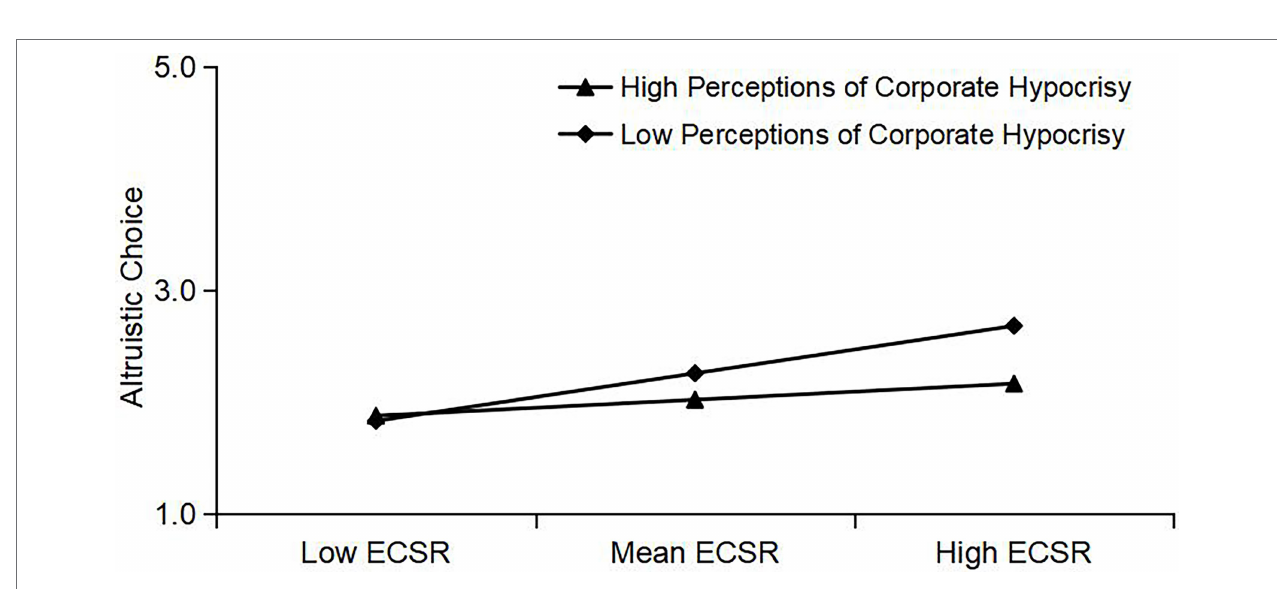
FIGURE 3 | External CSR and altruistic choice: moderating effect of perceptions of corporate